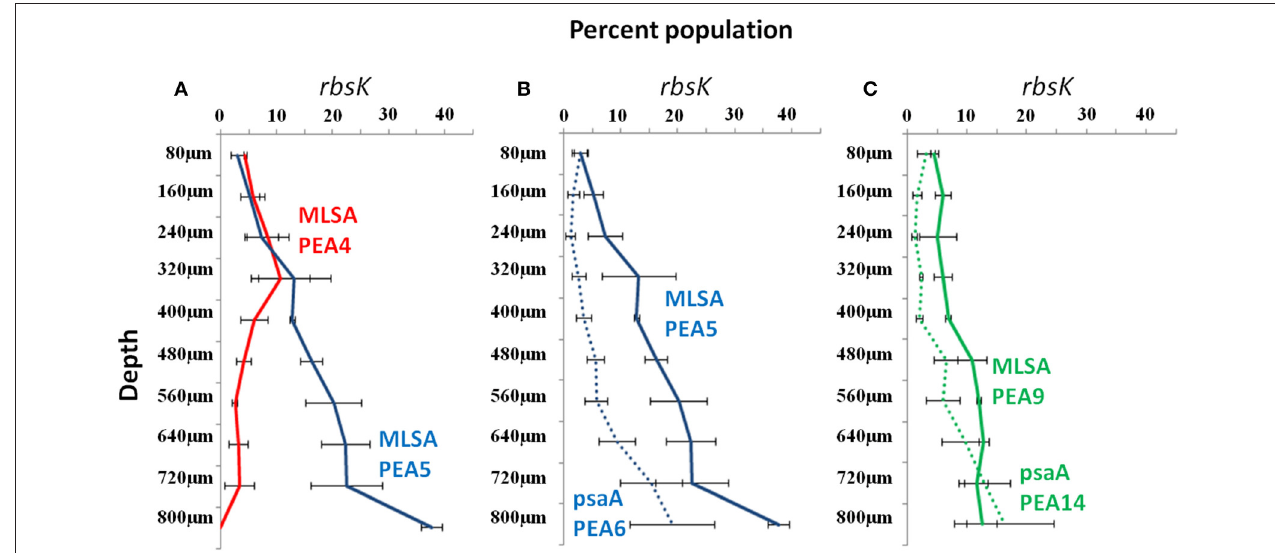
FIGURE 3 | rbsK vertical distributions in the 63–65 ◦ C Mushroom Spring microbial mat of dominant rbsK and psaA variants associated with Synechococcus putative ecotypes (PE) demarcated from multi-locus sequence analyses (MLSA) by Ecotype Simulation, shown as colored solid lines.